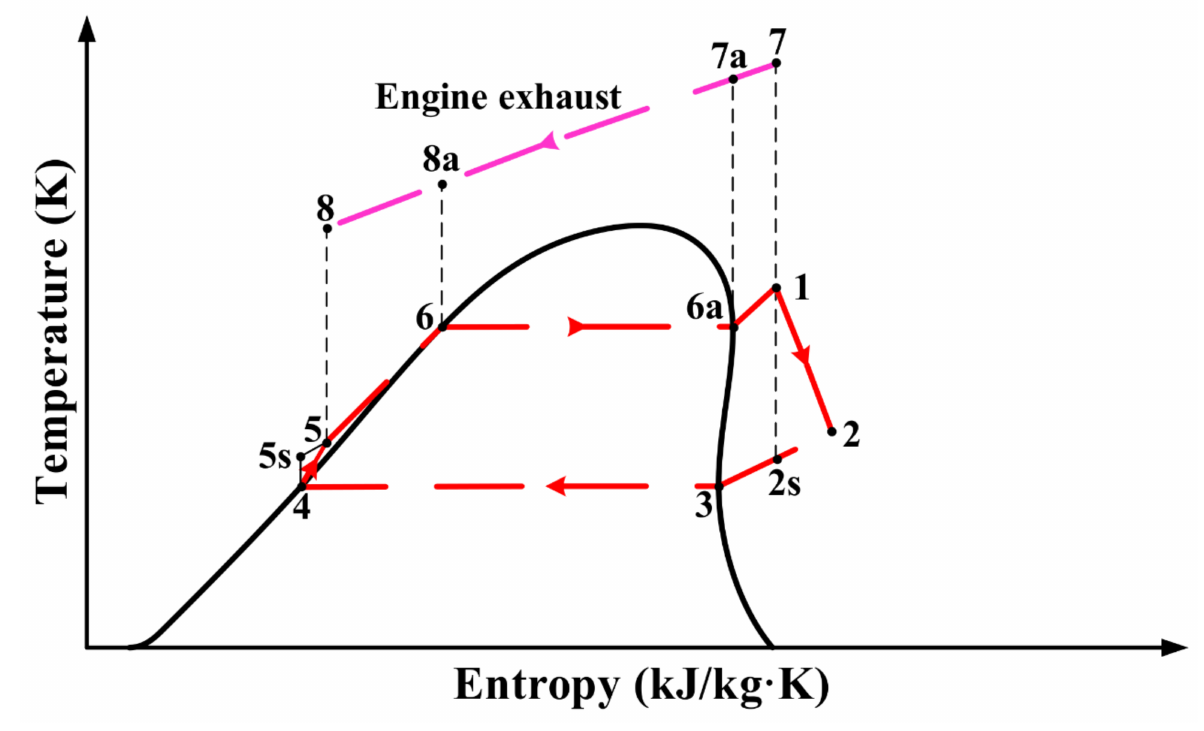
Figure 5. HT loop of the DORC system.